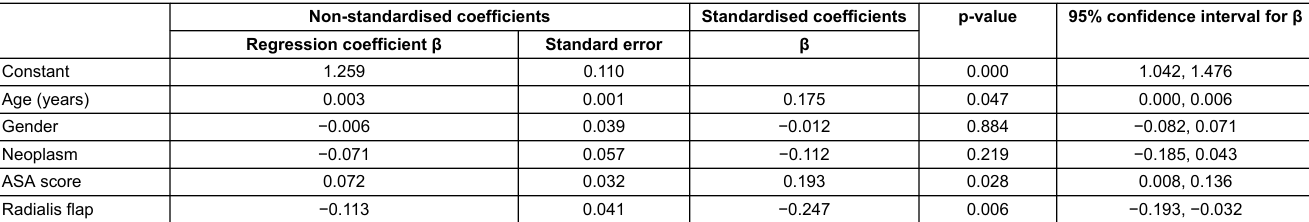
Table 5: Coefficients of linear regression with log CCI as the dependent variable (n = 129).